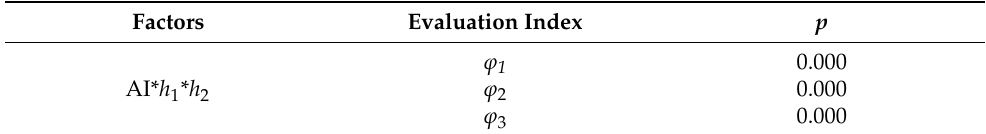
Figure 12. The maximum and minimum wake volumes of URs with different h 1 , h 2 , and AI. Table 2. The interaction among factors.